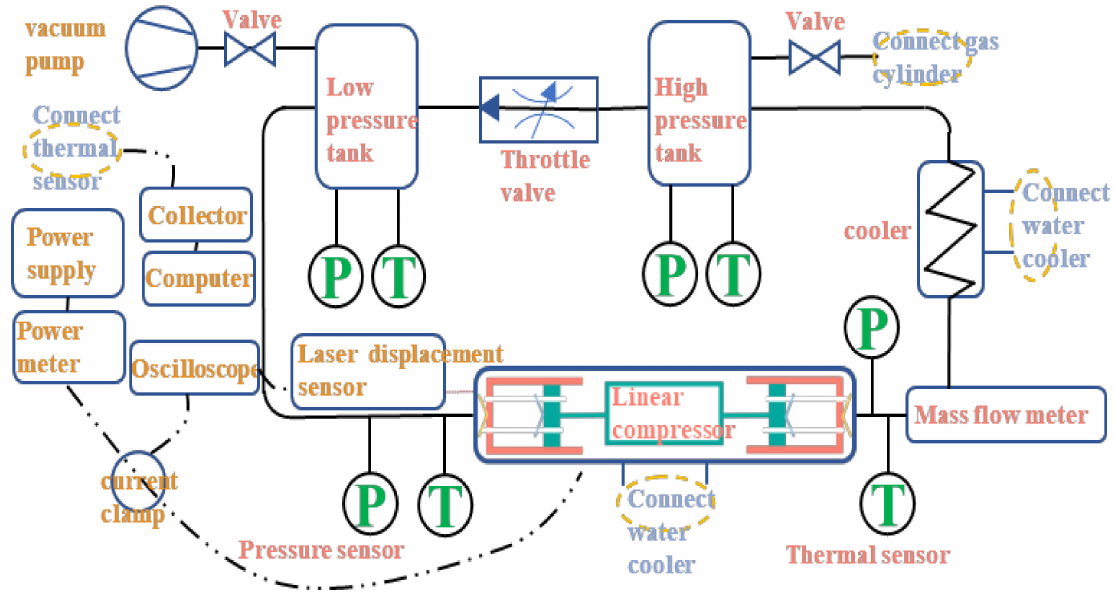
Figure 11. Schematic diagram of the experimental